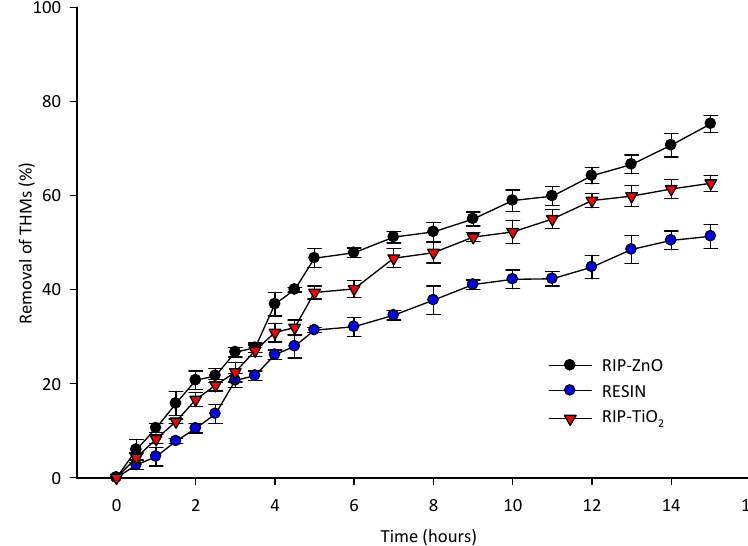
Fig. 4: The changing of THMs concentration in tofu wastewater under various processes of resin, RIP‐TiO 2 , and RIP‐ZnO